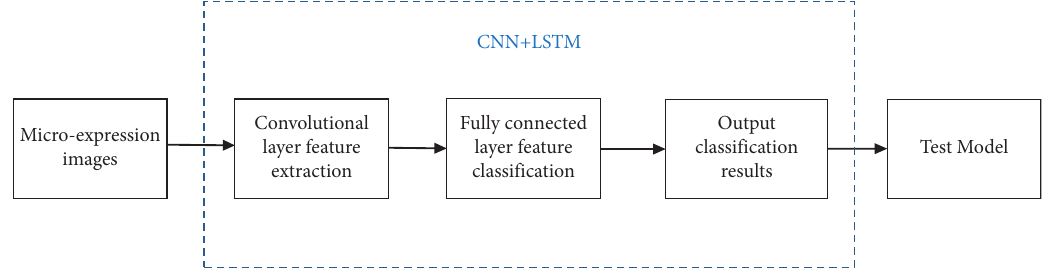
Figure 10: CNN +LSTM algorithm framework.